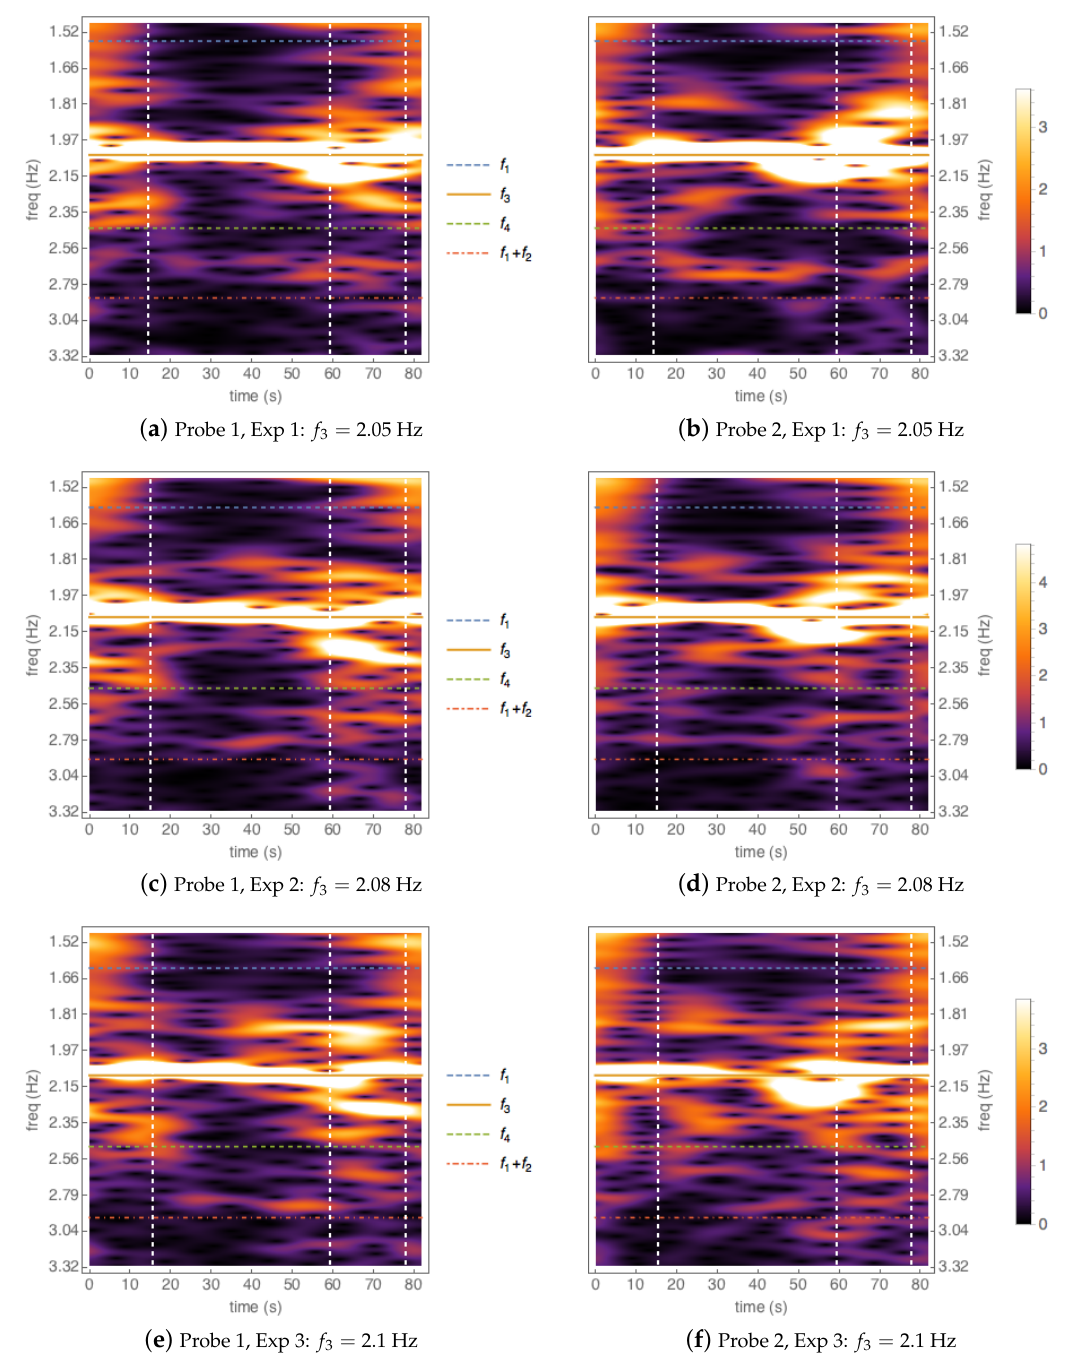
Figure 15. Scaleograms for measurements of probe 1 ( left panels ) and probe 2 ( right panels ), for experiments 1, 2 and 3. Frequencies are displayed in the vertical axis and time in the horizontal axis. Three of the main frequencies found in the experiments are marked in each panel: f 1 , f 3 , f 4 , along with f 1 + f 2 for reference. The rows from top to bottom correspond to experiments 1, 2 and 3: Starting from the top, f 3 / Hz = 2.05,2.08,2.1. The three vertical lines correspond, from left to right, to: (i) The theoretical time (which depends on the experiment) when the first nonlinearly-produced wavepackets with central wavenumbers ± K 1 arrive at the probes; (ii) the theoretical time (which is fixed) when the first wavepackets with central wavenumbers ± K 2 arrive at the probes after reflecting from the ends of the tank; (iii) the fixed time when the artificial signal’s scalogram shows a significant departure from the expected frequencies. See further comments on the colormaps and details of scaleogram calculations in the caption of Figure